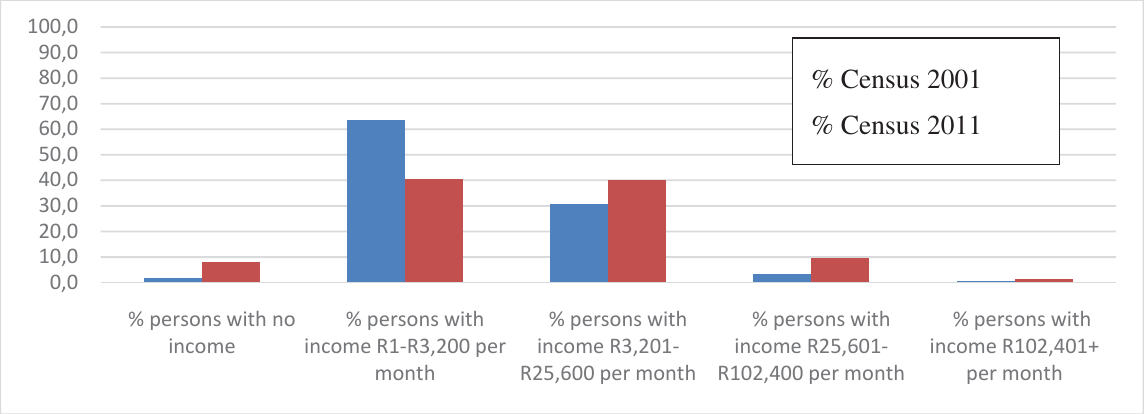
Fig. 8. Growth in the number of persons/households in the different income categories census 2001/2011 Source: Stats SA Computed by E Udjo (2016).